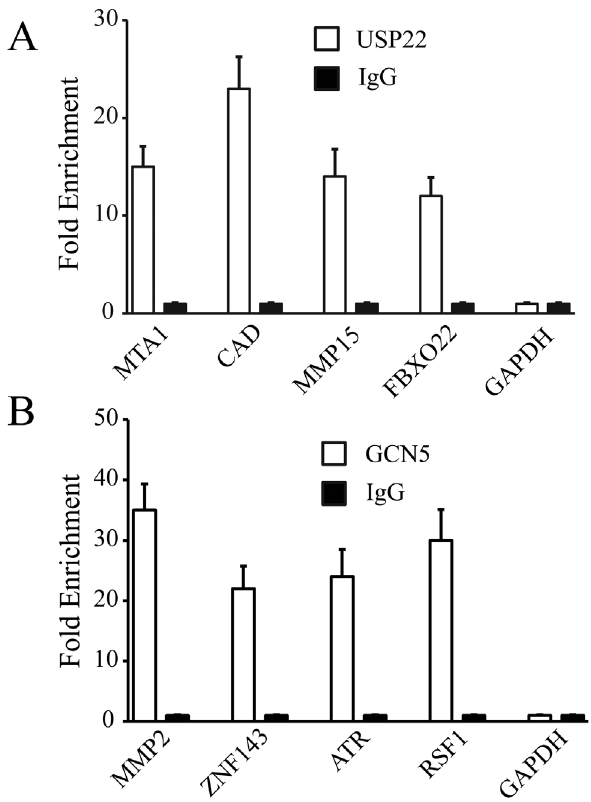
Figure 2 - ChIP-PCR analysis of the selected USP22 or GCN5 binding sites. ChIP-qPCR was used to amplify chromatin derived from immuno- precipitations with (A) anti-USP22 antibody or (B) anti-GCN5 antibody as indicated. The levels of control IgG bound genes were designated as 1. Each data point represents the average of two independent ChIP experi-